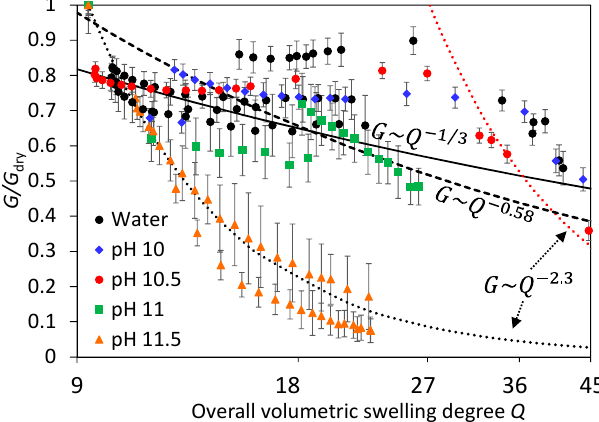
Figure 5. Shear modulus during swelling experiments in different solutions normalized against the initial modulus of the dry unswollen gels (before being submerged in solution). Error bars show the standard deviation of the moduli calculated between 50–500 μ m indentation depths for three replicates in different locations. Lines show several theoretical scaling laws for neutral polymer gels as a comparison.